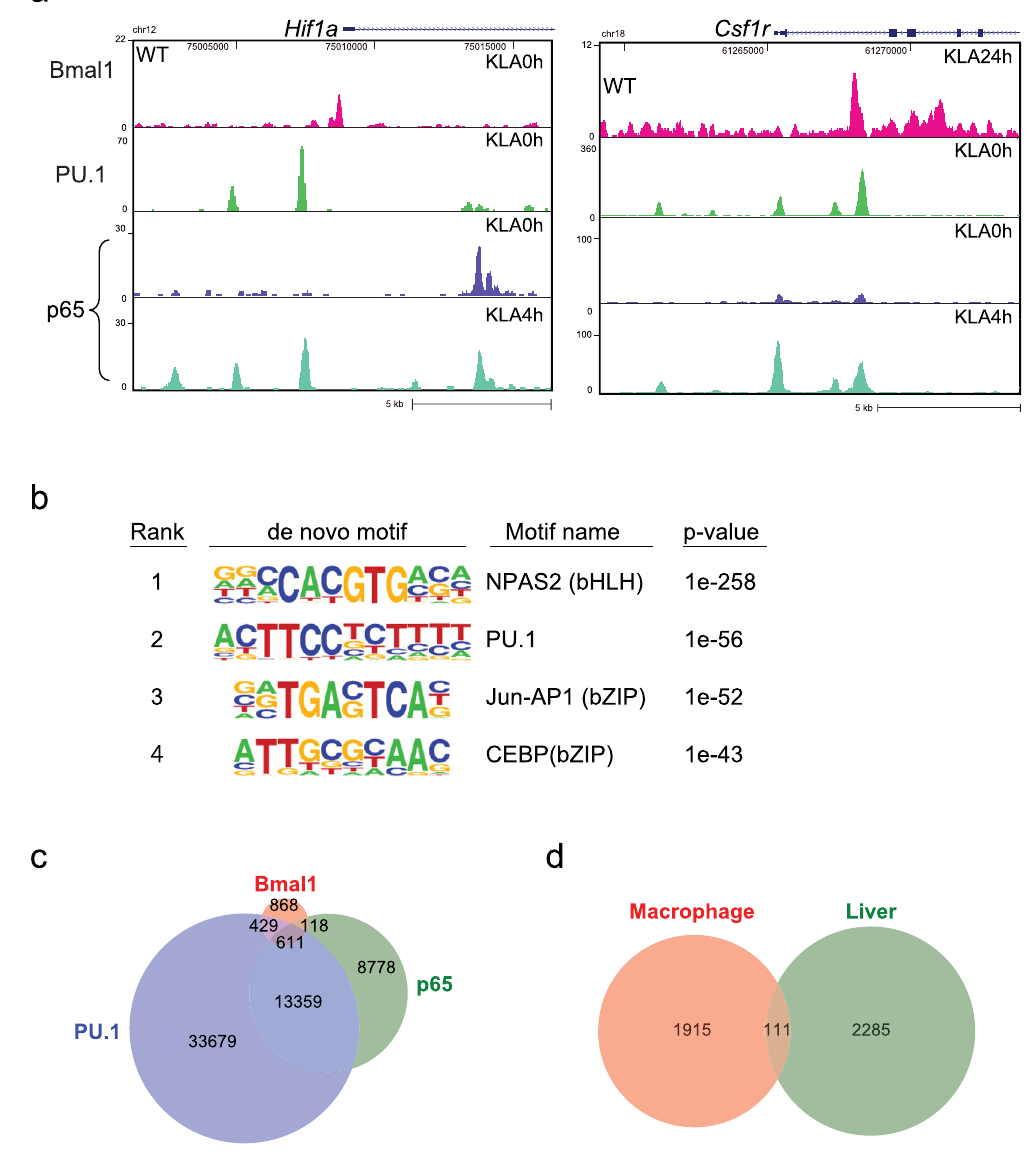
Figure 3. Bmal1 co-localizes with PU.1 and NF- κ B. ( a ) UCSC genome browser image illustrating normalized tag counts for ChIP-seqs of Bmal1, PU.1, and p65 around the Hif1a and Csf1r loci. ( b ) de novo motifs identified in regions bound by Bmal1 in macrophages. ( c ) Venn diagram showing the overlap between the PU.1, p65 and Bmal1 peaks identified using ChIP-seq. Note more than half of the Bmal1 peaks (1,158 of 2,026 peaks) were also bound by PU.1 and/or NF- κ B p65. ( d ) Venn diagram showing the overlap between Bmal1 peaks in macrophages and